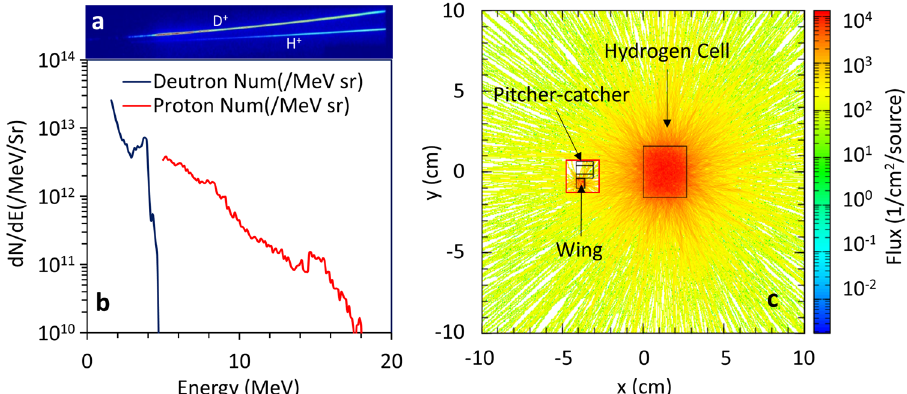
Figure 3. Ion-driver spectrum with corresponding neutron simulation. ( a ) Shows a typical proton and deuteron raw data obtained using 5μm5μm Au foil with TP, with respected spectra shown in ( b ). ( c ) shows the PHITS Monte-Carlo simulation performed for the cold neutrons (≤ 25 meV ≤ 25 meV) in the hydrogen moderator, confirming an isotropic nature of the moderated neutrons.